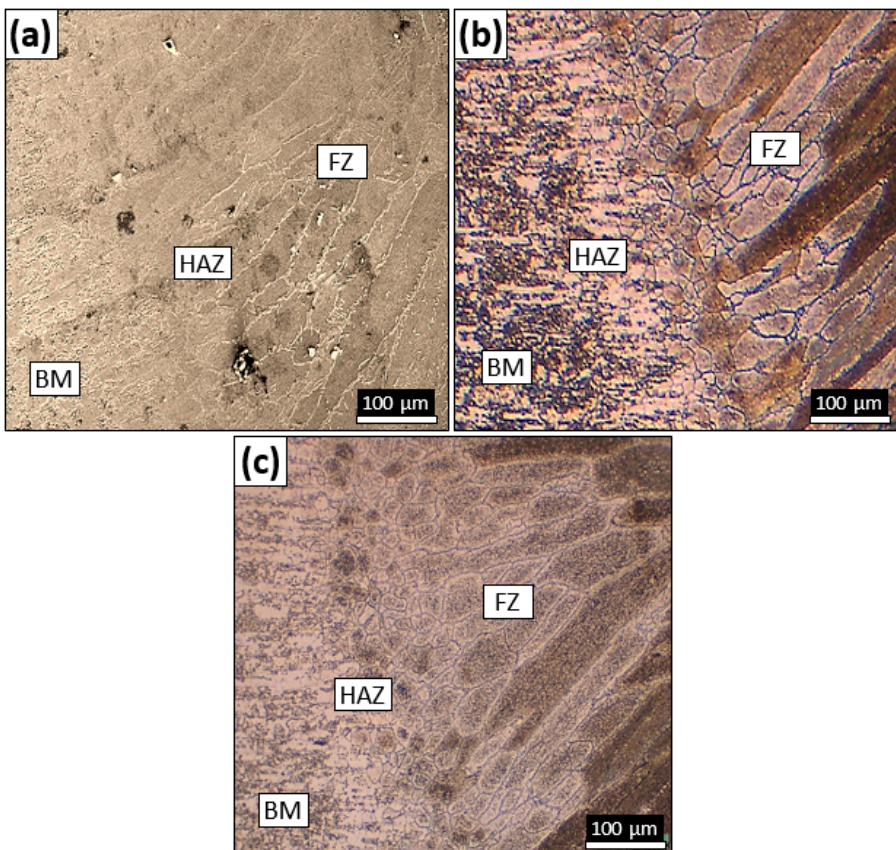
Figure 2. Optical micrographs of the laser-overlapped welded joint formed using ( a ) 4.5 kW ( b ) 6.5 kW and ( c ) 8.5 kW power. [BM: base metal; HAZ: heat-affected zone; FZ: fusion zone].